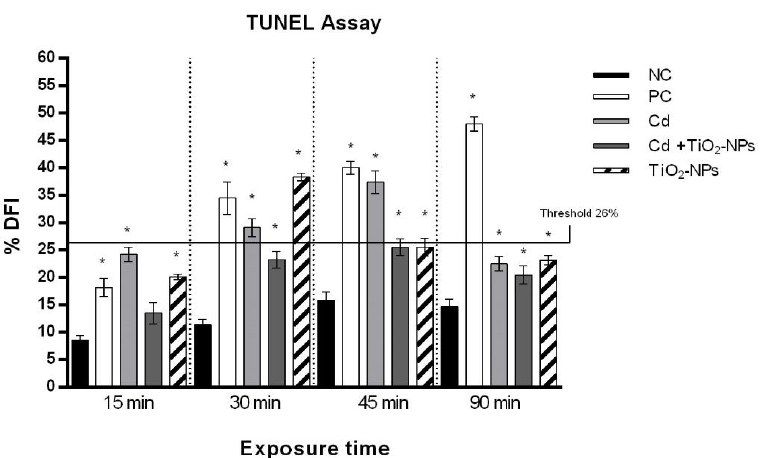
Figure 5. Percentage of DNA fragmentation index (ordinate) in human sperm after different exposure times (abscissa) to CdCl 2 and CdCl 2 +TiO 2 NPs co-exposure. The black bars are negative controls (NC); the white bars are positive controls (PC) (benzene 0.4 μL/mL); the light grey bars are 10 µM CdCl 2 - treated sperm (Cd); the dark grey bars are 10 µM CdCl 2 + 1 μg/L TiO 2 NPs-treated sperm (Cd + TiO 2 - NPs); the striped bars are 1 μg/L TiO 2 NPs-treated sperm. * p ≤ 0.01.